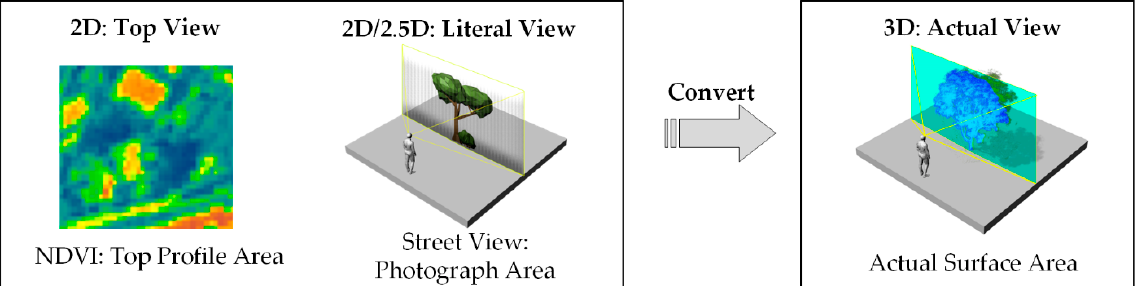
Figure 2. Comparison of the 2 ‐ D, 2.5 ‐ D, and 3 ‐ D observation areas.